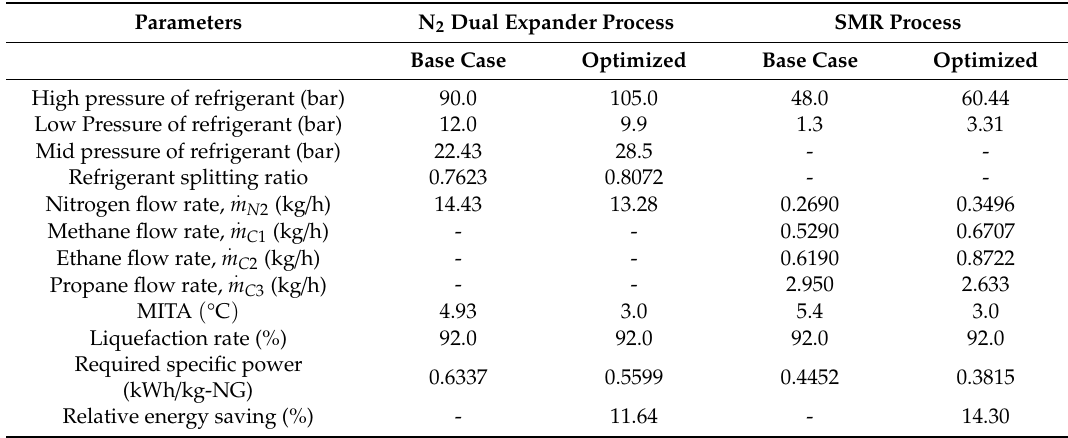
Table 11. Optimization results: summary and